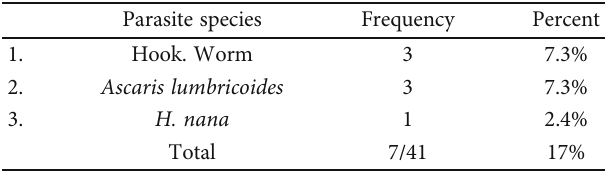
Table 4: Prevalence of intestinal helminths in the study